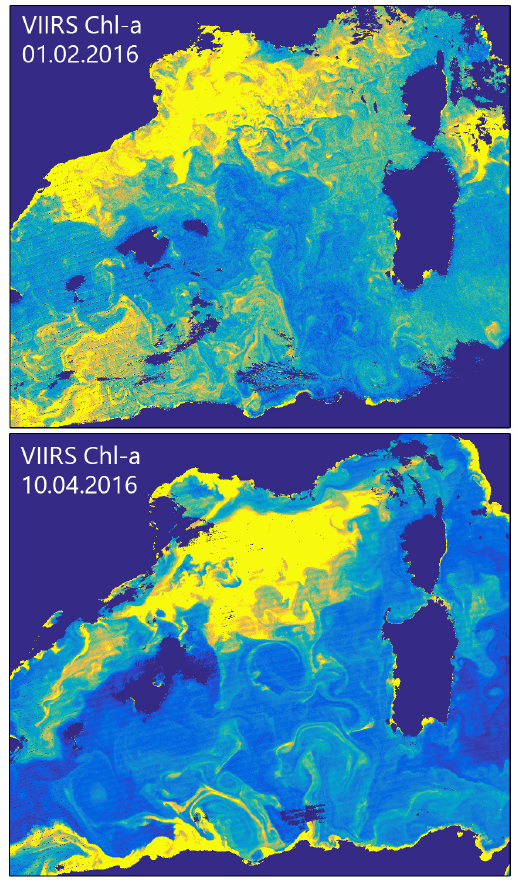
Figure 1. Snapshots of surface circulation in the Western Mediterranean during the cold (upper panel) and warm (lower panel) periods of year captured by the fields of Chl-a